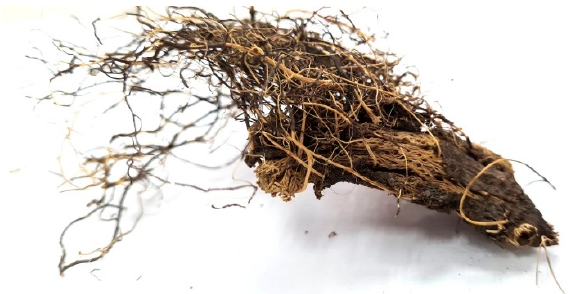
Figure 2. Rhaponticum carthamoides rhizome.